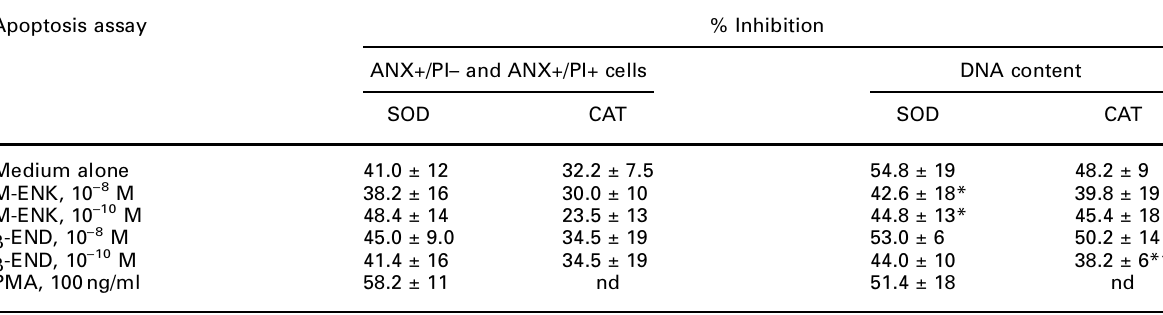
Table 3. Inhibition of spontaneous and opioid peptide-mediated neutrophil apoptosis by exogenous SOD and CAT Apoptosis